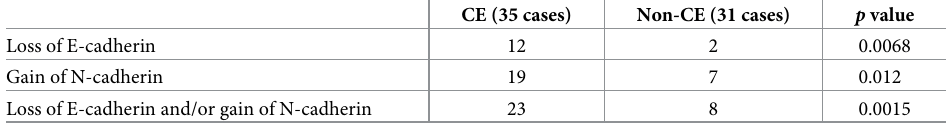
Loss of E-cadherin and/or gain of N-cadherin 23 0.0015 CE, chronic endometritis. A Fisher analysis was used to compare the difference.